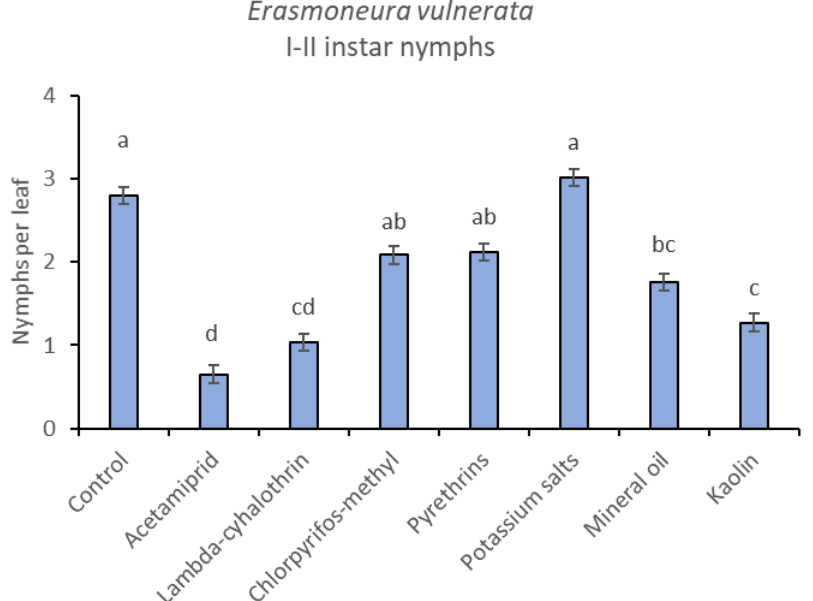
Figure 9. Least-square means ( ± std. err.) of Erasmoneura vulnerata early (I-II instar) nymphs observed on different treatments in the 2018 trial. Different letters indicate significant differences at t -test ( α = 0.05).